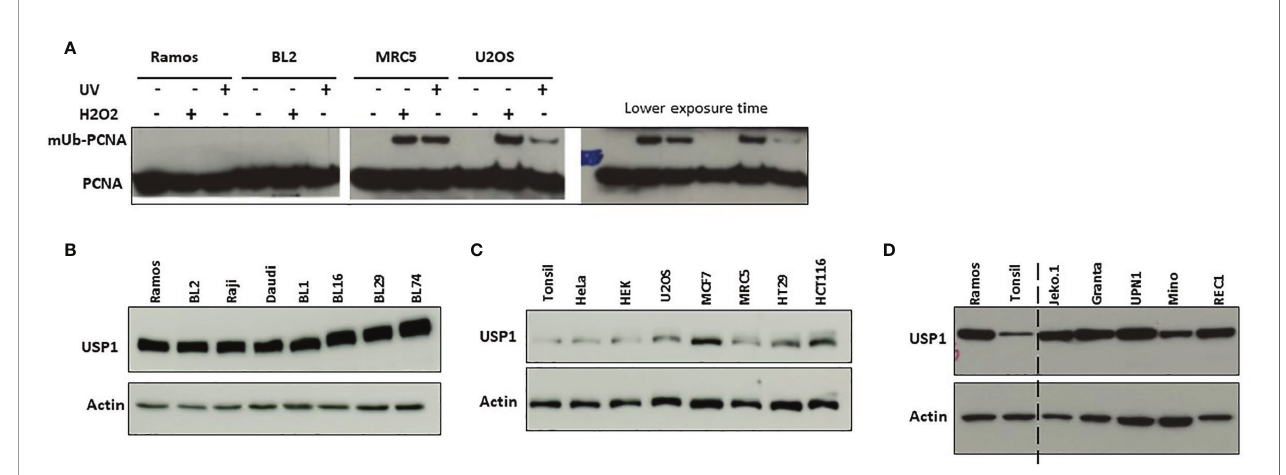
FIGURE 1 | Induction of monoubiquitination of PCNA and USP1 expression in Ramos and BL2 cells. (A) B cell lines Ramos and BL2 cells (left pannel) and non- B cells MRC5 and U2OS cells (right pannel) were exposed to UVC light (10 J/m 2 ) or incubated in the presence of H 2 O 2 as indicated in the M&M. Total protein extracts were prepared 2 hours post-treatment, separated by SDS – PAGE and analyzed by immunoblotting using an anti-PCNA antibody. (B, C) Protein extracts were prepared from the indicated cell lines and analyzed as described above using an anti-USP1 antibody. In B – D actin was used as loading control. (D) Protein extracts from Ramos and Tonsillar B cells were loaded side by side to facilitate